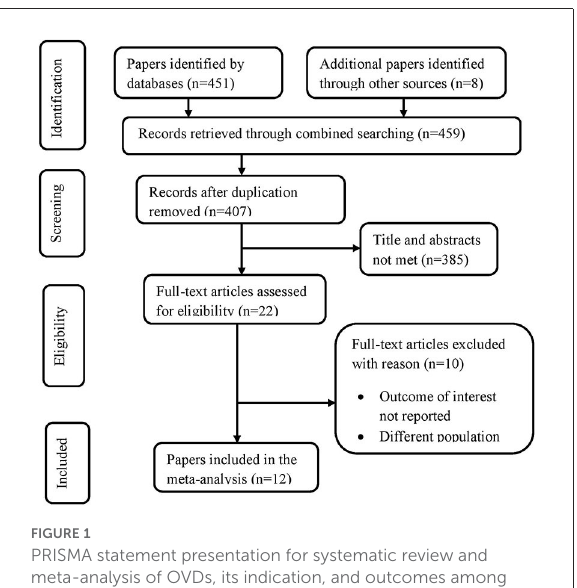
FIGURE1 PRISMA statement presentation for systematic review and meta-analysis of OVDs, its indication, and outcomes among mothers who give birth in Ethiopia, 2022. n, number of studies included at each